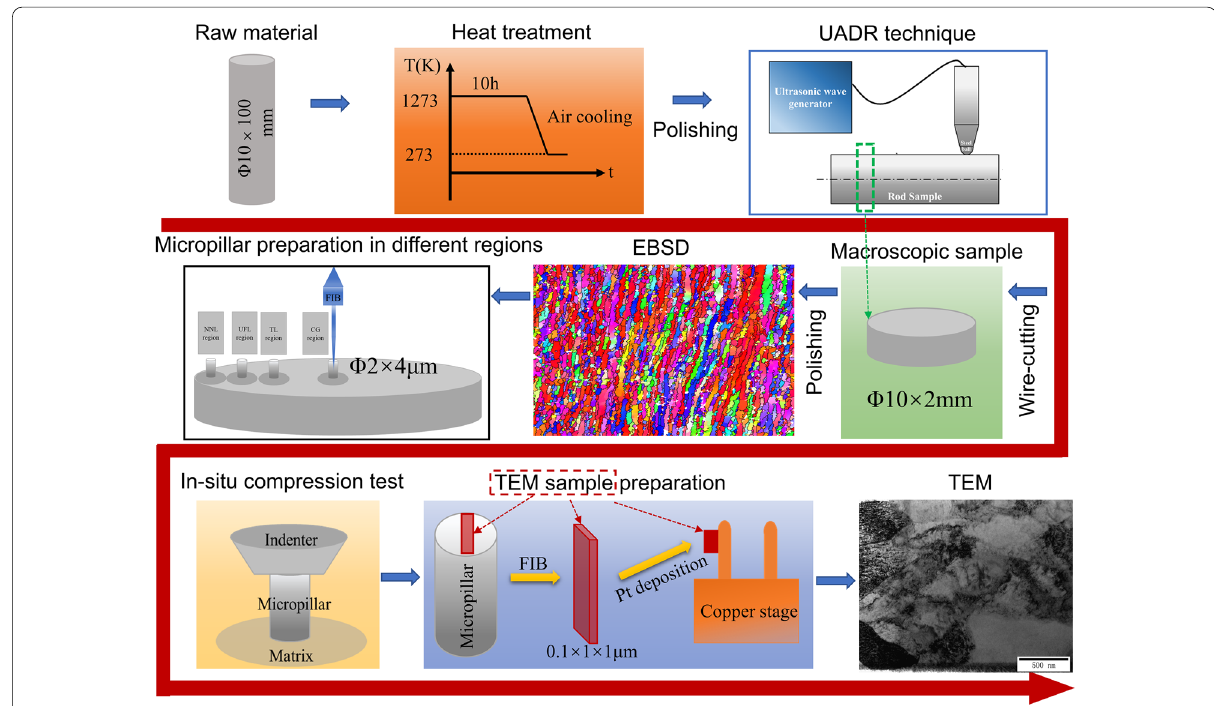
Figure 1 Schematic image of main procedures in this work